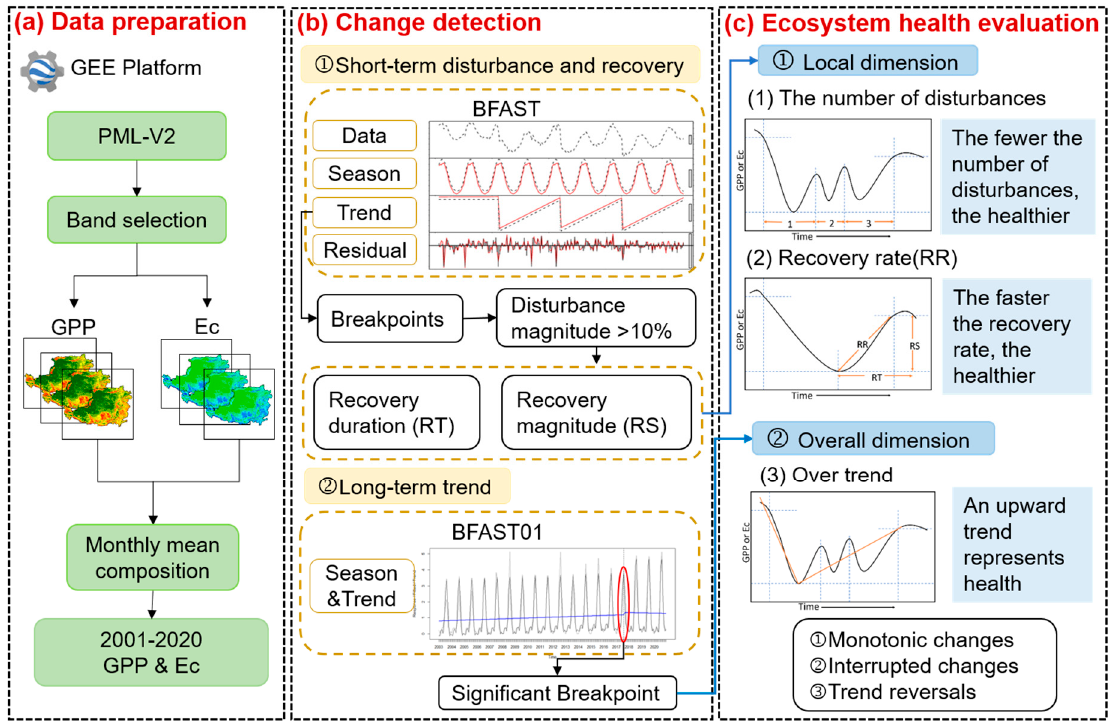
Figure 2. Workflow of the research method applied in this study; Google Earth Engine,